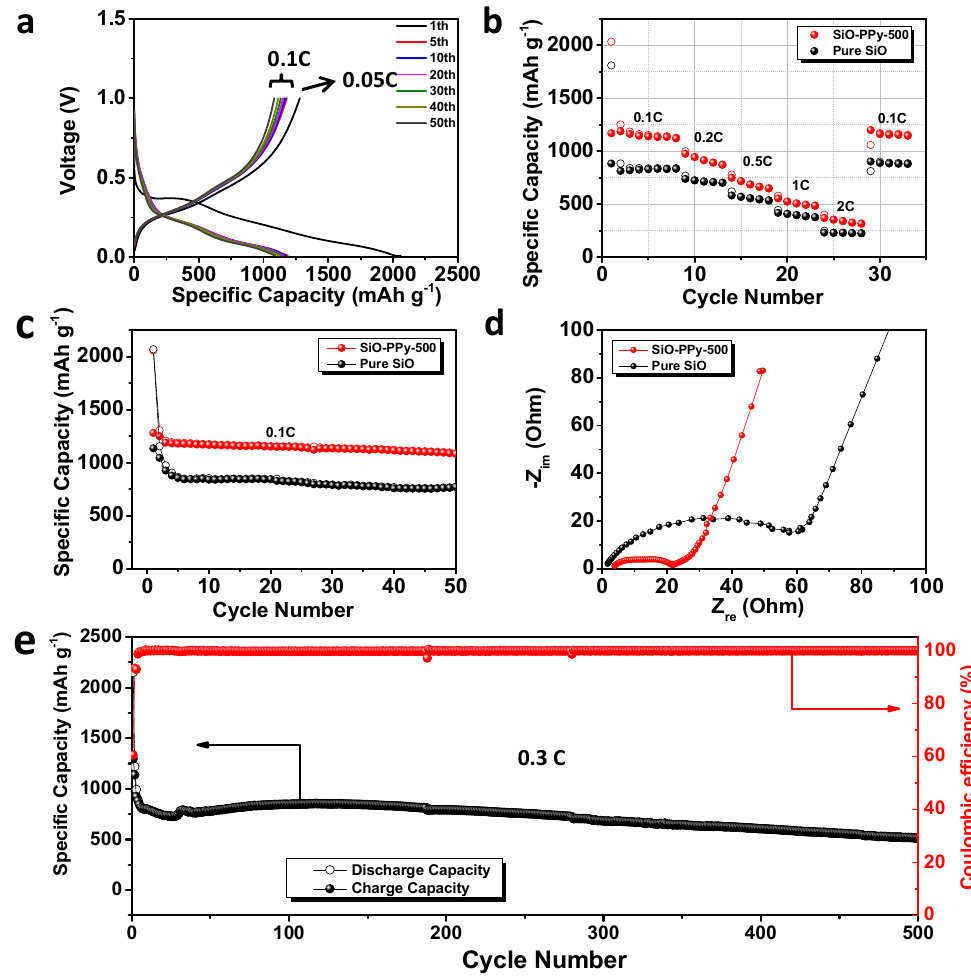
Figure 3. Electrochemical performance of the pure SiO and SiO–PPy–500 composite electrode: ( a ) discharge/charge profiles of SiO–PPy–500 measured at 0.05 C for the first cycle and then 0.1 C for 50 cycles; ( b ) the rate capabilities of pure SiO and SiO–PPy–500 at various current densities; ( c ) cycling performance at current densities of 0.1 C; ( d ) Nyquist plots of pure SiO and SiO–PPy–500 composite electrode after 50 cycles; and ( e ) long-term cycling performance of SiO-PPy-500 at the current rate of 0.3 C for 500 cycles.